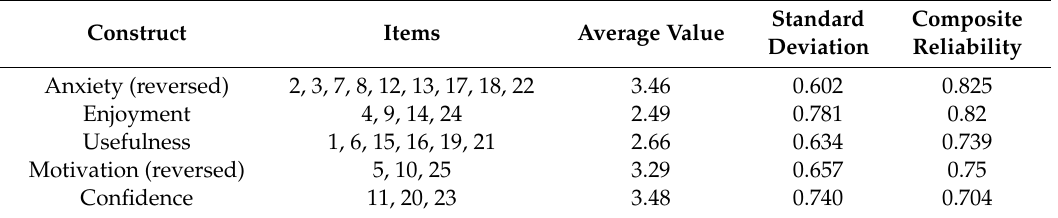
Table 2. Constructs of